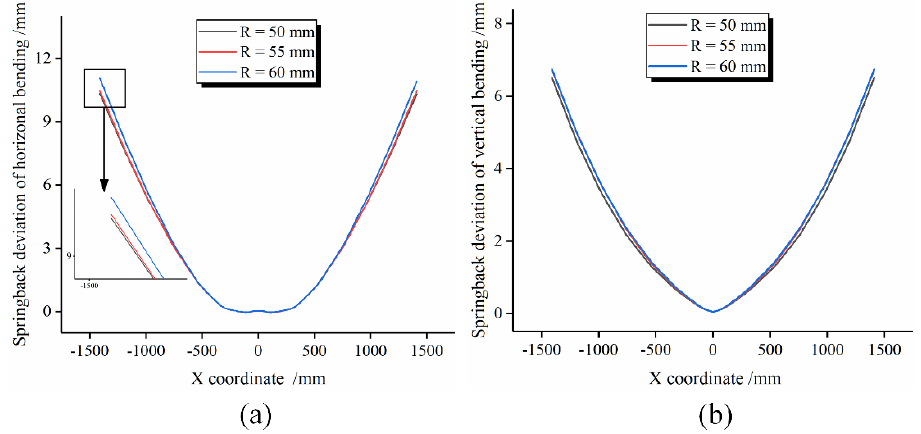
Figure 10. Springback deviation with different radii of roller dies. ( a ) Springback deviation of horizonal bending. ( b ) Springback deviation of vertical bending.